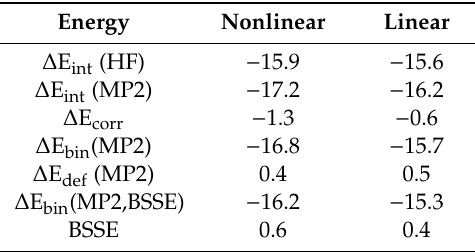
Table 1. The energetic characteristics (in kcal / mol) of the linear and nonlinear configurations of the BF 4 − ... HCN